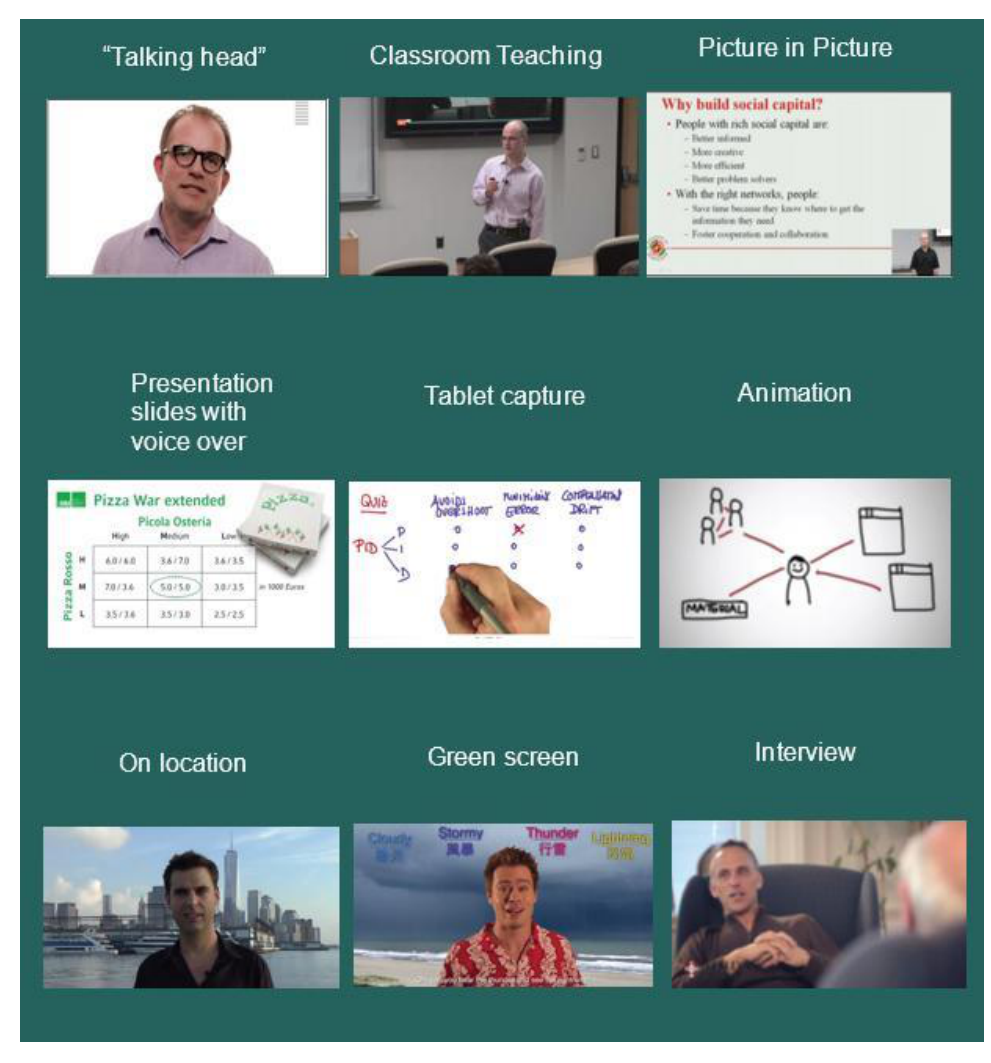
Figure 1. Video design patterns. Source: modified from Hansch et al.